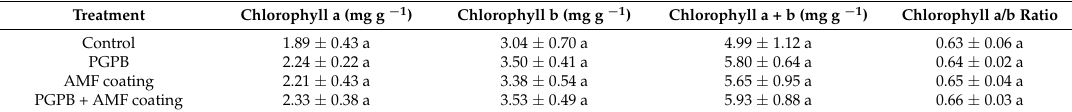
Table 2. Chlorophyll contents in leaves of